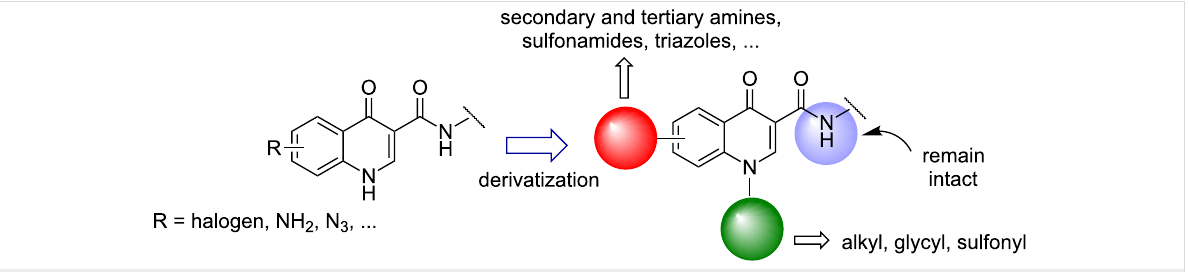
Figure 2: Structural modifications on the 4-oxo-1,4-dihydroquinoline-3-carboxamide scaffold.